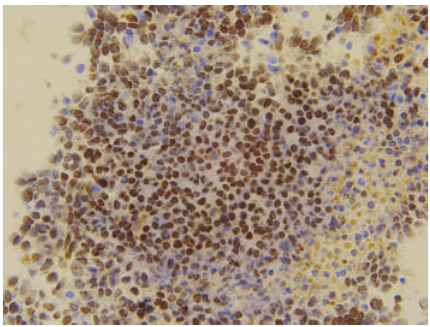
Figure 4: Papanicolaou-stained smear showing a necrotic back- ground containing naked nuclei, karyorrhectic debris, apoptotic cells, and macrophages phagocytizing karyorrhectic debris.